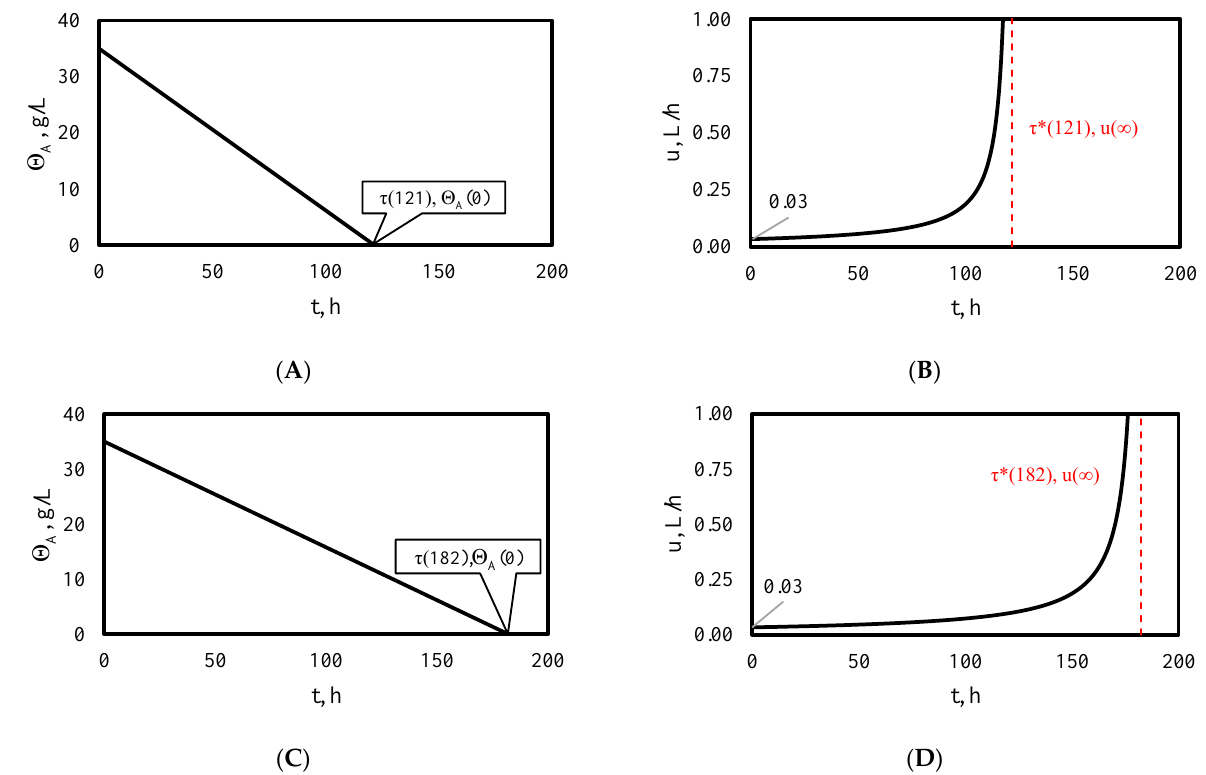
Figure 7. Route of the state of lubrication system with a regulator. ( A ) Profile of the difference in partial densities of lubricant precursors between the oil pan and the engine for 4 L of lubricant in the oil pan, ( B ) Profile of the difference in partial density of lubricant precursors between the oil pan and the engine for 6 L of lubricant in the oil pan, ( C ) Optimal lubricant supply path to the inside of the engine for 2 L of lubricant in the oil pan, and ( D ) Optimal lubricant supply path to the inside of the engine for 6 L of lubricant in the oil pan.